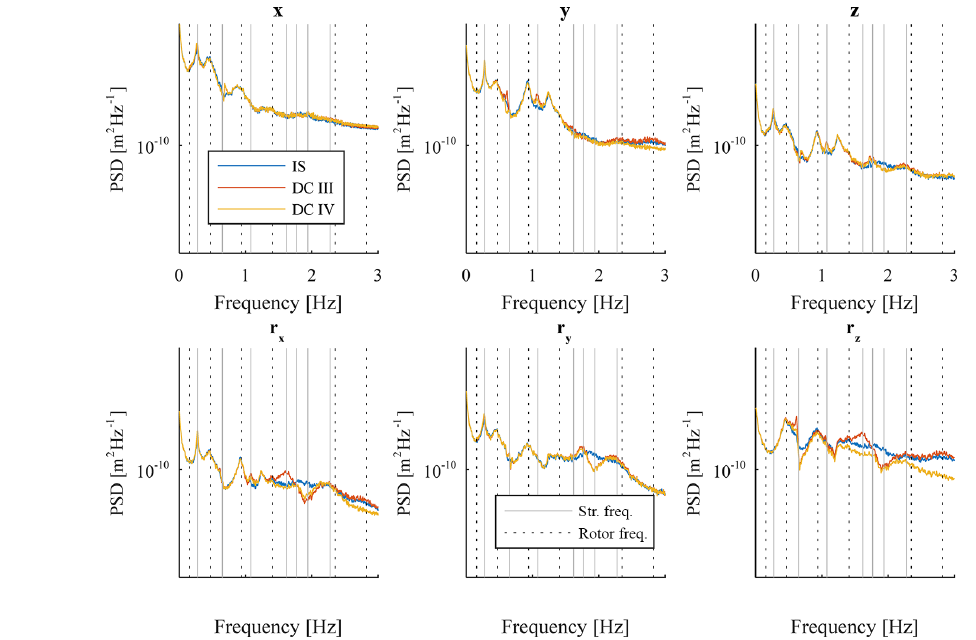
Figure 13. PSD for tower top displacements of DC III and DC IV with a wind speed of 8ms − 1 .